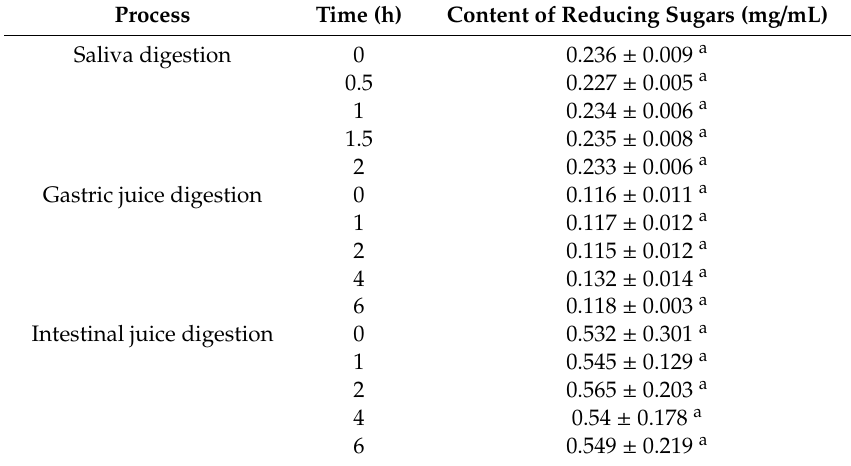
Table 1. Reducing sugar of FSP during digestion of saliva, gastric and small